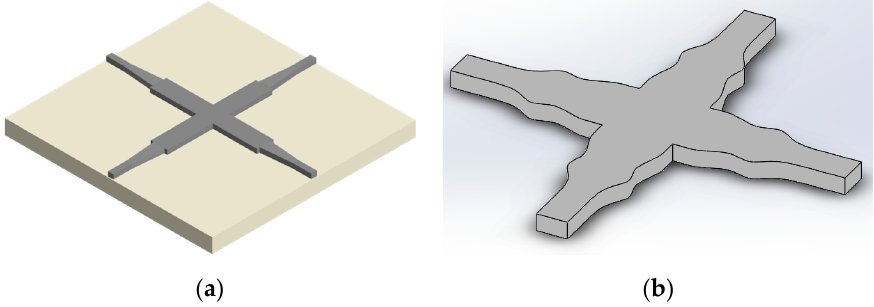
Figure 3. Schematics of ( a ) the traditional multimode interference (MMI) silicon waveguide crossing with taper transition and ( b ) the three cascaded multimode tapers silicon waveguide crossing.